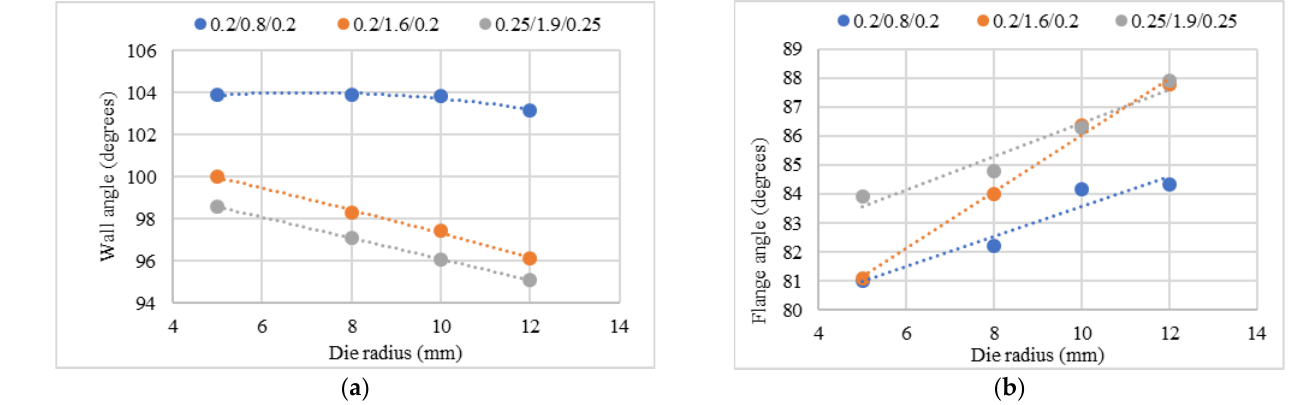
Figure 15. Effect of die radius on ( a ) wall angle and ( b ) flange angle after springback for three different sandwich laminate thickness combinations and a constant punch radius of 8 mm.